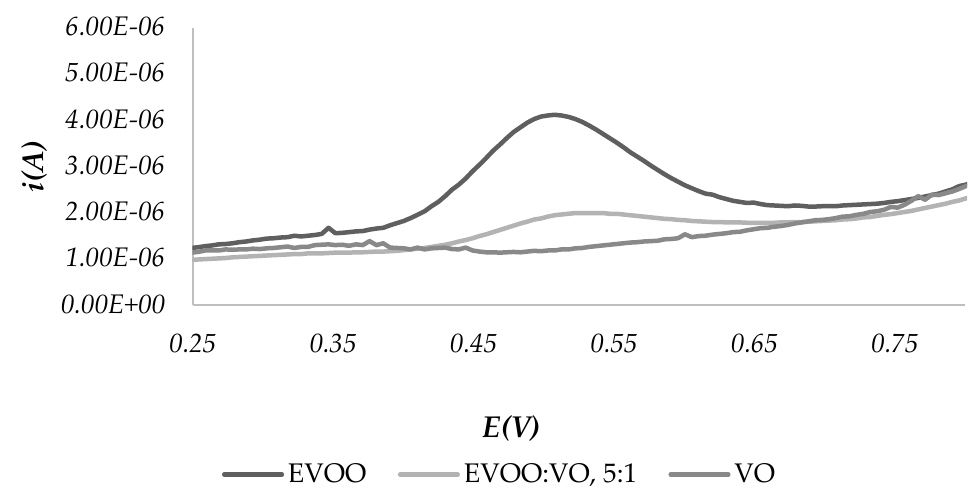
Figure 4. SWV-A scans for the comparison of a mixture of EVOO and SSO with the pure oils. It is possible to observe that a small amount of SS significantly changes the redox